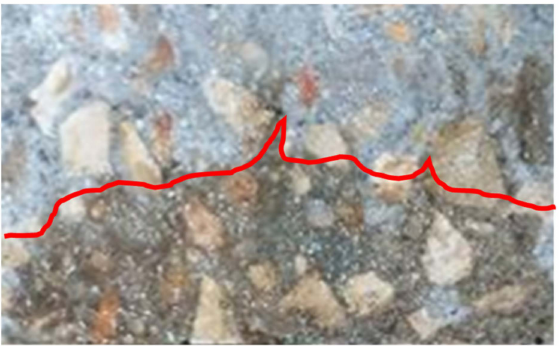
Figure 6. Specimens split for chloride penetration depth measurement after 96 h at 60 V. Non-steady-state migration coefficients (D nssm ) for A and B concrete specimens are given in Figure 7.